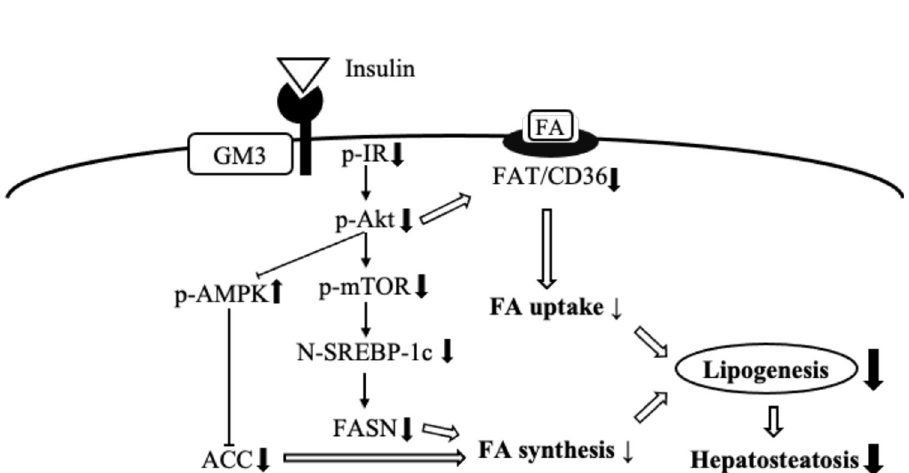
Fig 8. Regulatory roles of GM3 in hepatic insulin signaling, leading to the protection from hepatosteatosis. A schema to summarize the results of this study.